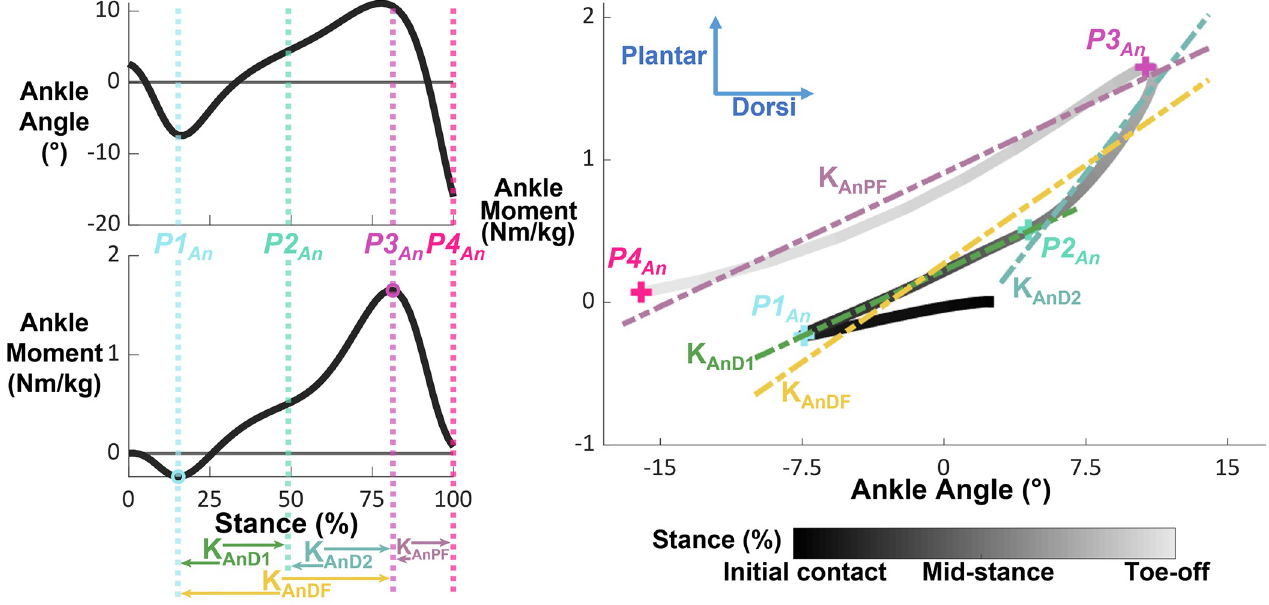
Fig 1. Ankle angle, moment, and moment-angle relationships during stance phase overlaid with points of interest and phases of quasi-stiffness. The smaller subplots on the left show ankle angle and moment during stance phase. The dashed vertical lines represent the timings of each point of interest, while the open circles identify the point of interest itself. The phases of quasi-stiffness are identified at the bottom of these plots, with the arrows indicating their onset and termination. The large, right figure shows the moment-angle relationship with the quasi-stiffness overlayed as dashed lines and the points of interests as “+”. Data for visualization were normalized to 60 data points and averaged across all participants walking in normal gravity at 1.6 m/s. Direction of internal joint moment and joint angle are indicated with arrows on the rightmost